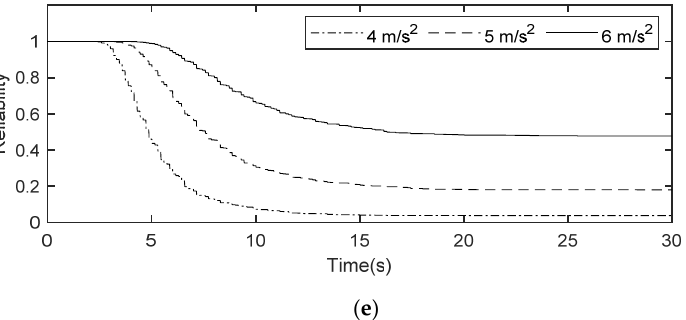
Figure 12. Reliability analysis for the large-span concrete plate on different parameters: ( a ) Criteria; ( b ) Bouncing frequency; ( c ) CSI effect; ( d ) Human parameter distribution; ( e ) Threshold.